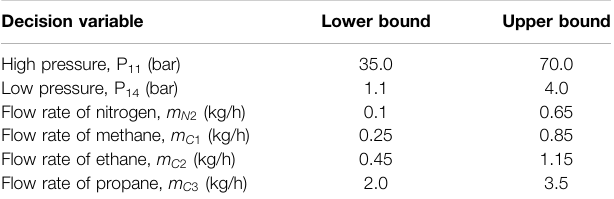
TABLE 3 | Decision variables of the SMR process with their upper and lower